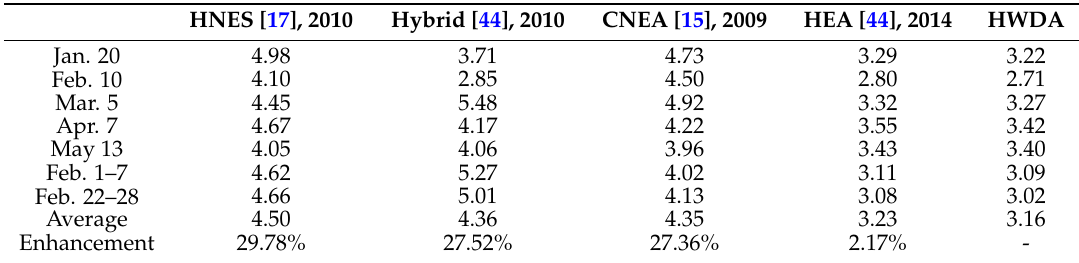
Table 4. MAPE (the mean absolute percentage error) comparison considering the year 2006 PJM (Pennsylvania-New Jersey-Mary) land market case study for 24/168 h ahead.